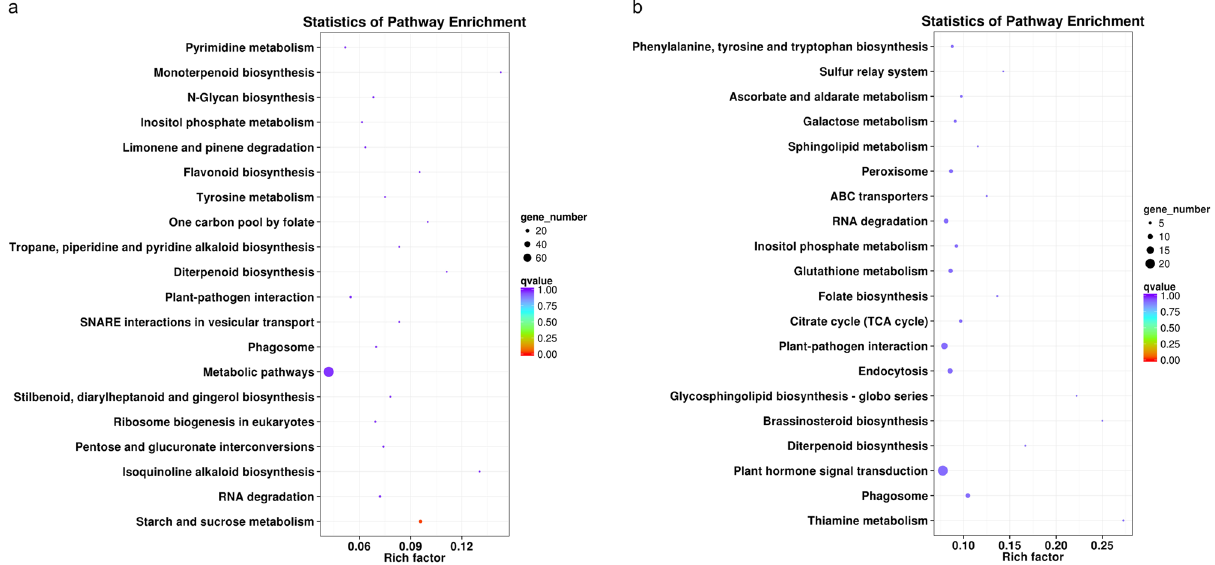
Figure 8. Kyoto Encyclopedia of Genes and Genomes analysis of target genes of DELs in ABA vs. CK ( a ) and RT vs. CK ( b ). The dot size indicates the number of enriched target genes of DELs in each pathway, and the different color of the dot represents the corrected P -value of each pathway. The top 20 enriched KEGG terms ranked by the corrected P -value are